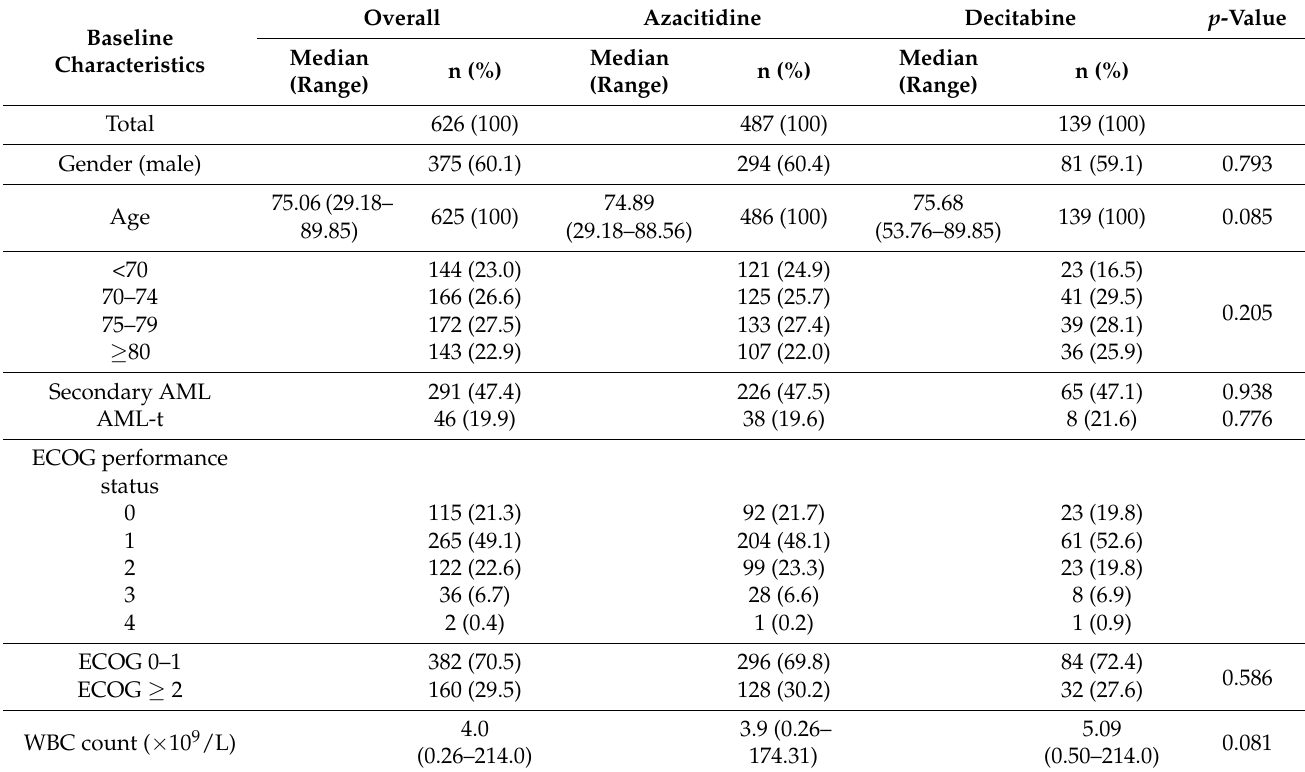
Table 1. Baseline characteristics of the study